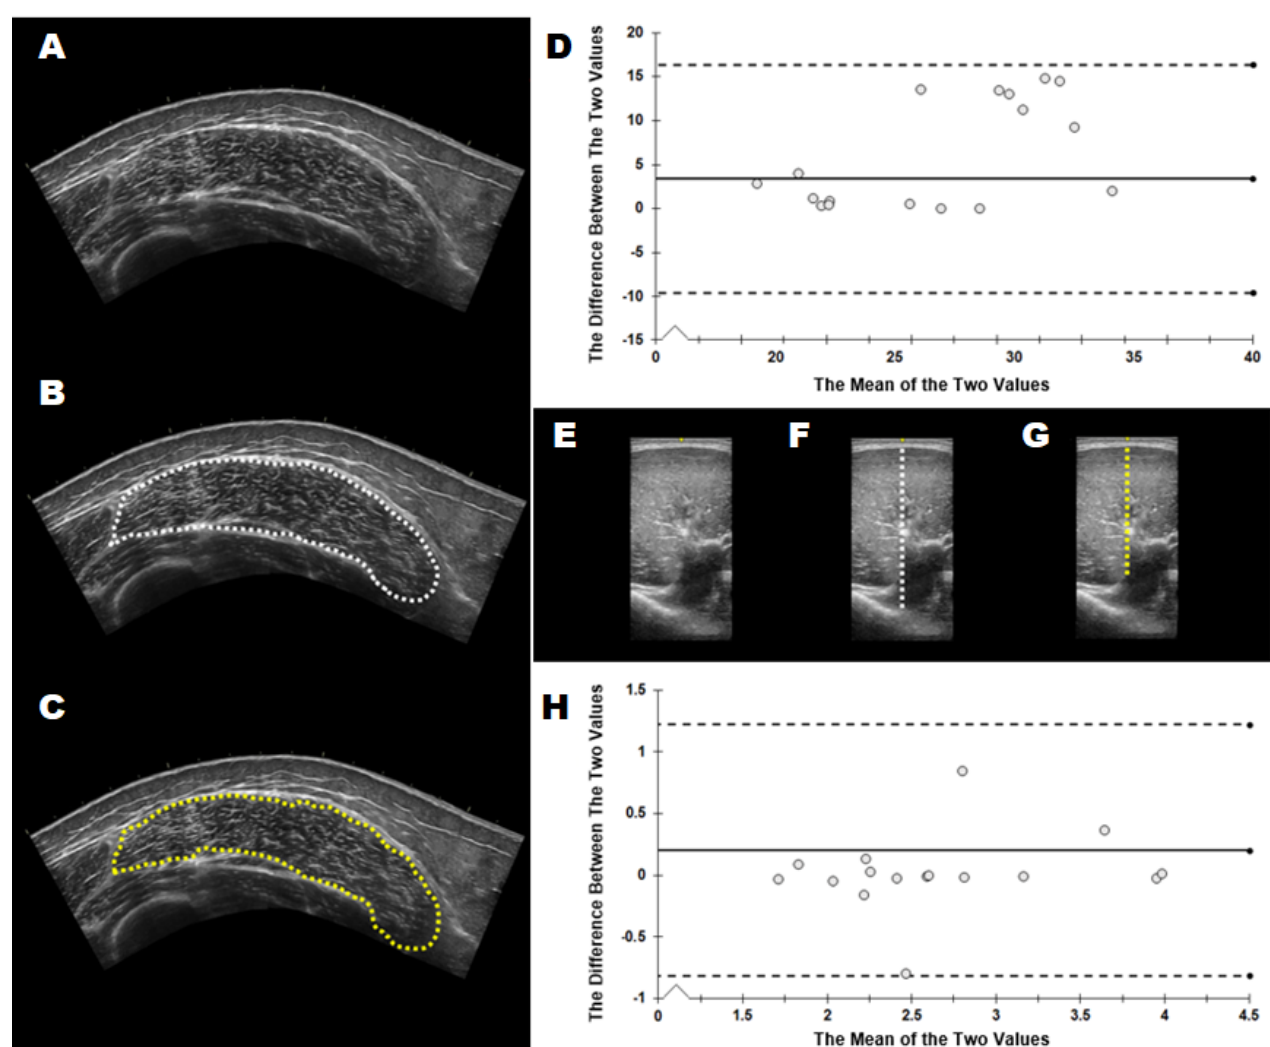
Figure 2. Acquired images ( A , E ) from the experienced sonographer (M.S.) were analyzed by the experienced analyst ( B , F ) and the novice analyst ( C , G ). Representative images for the variables that were significantly different between analysts during image analysis are shown: cross sectional area of the vastus lateralis ( B , C ) and transverse thickness of the biceps brachii ( F , G ). Bland Altman plots are shown for vastus lateralis cross-sectional area ( D ) and biceps brachii thickness ( H ). Dotted lines: 95% limits of